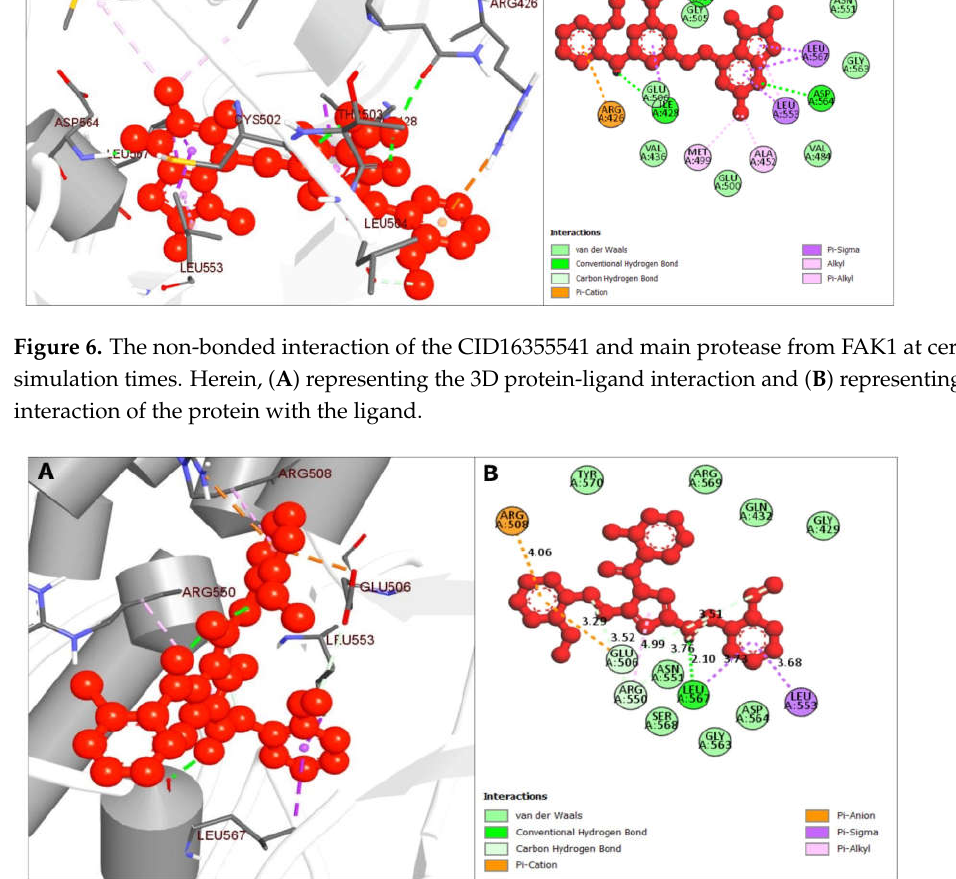
Figure 7. The non-bonded interaction of the CID16467343 and main protease from FAK1 at certain simulation times. Herein, ( A ) representing the 3D protein-ligand interaction and ( B ) representing 2D interaction of the protein with the ligand.